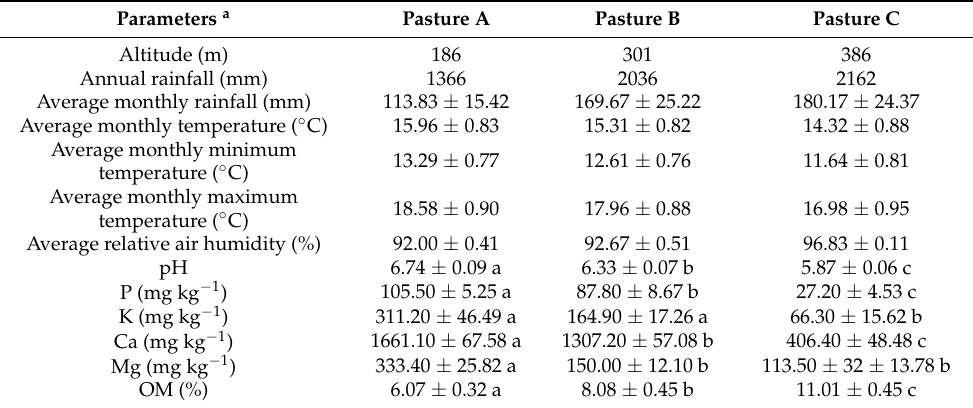
Table 1. Climatic and soil parameters in the sampling pastures A, B and